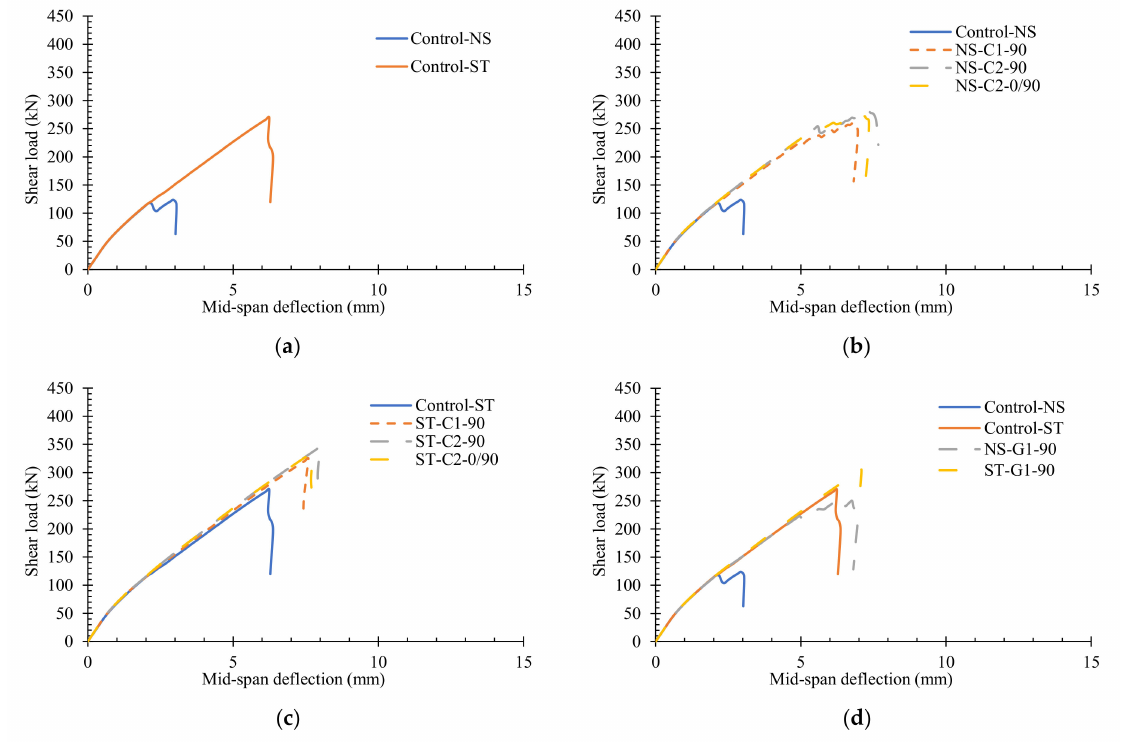
Figure 18. Predicted shear load–deflection response: ( a ) Control beams; ( b ) Group A; ( c ) Group B; ( d ) Group